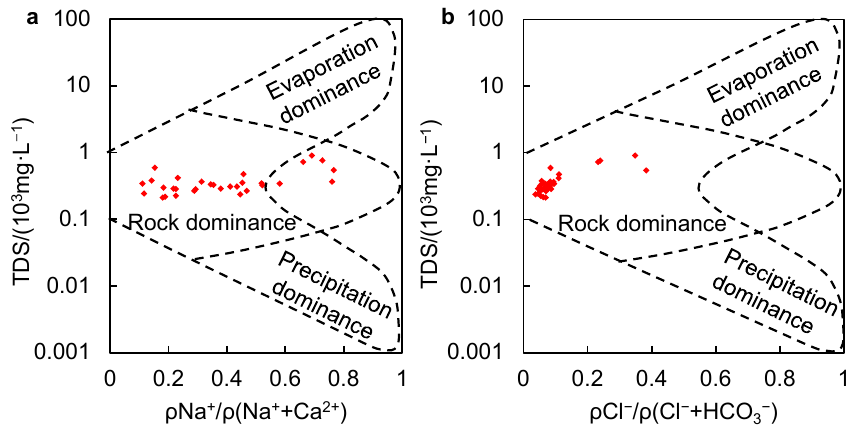
Figure 3. Gibbs diagrams of groundwater samples. ( a ) ρ Na + / ρ (Na + +Ca + ); ( b ) ρ Cl − / ρ (Cl − +HCO 3 − ).